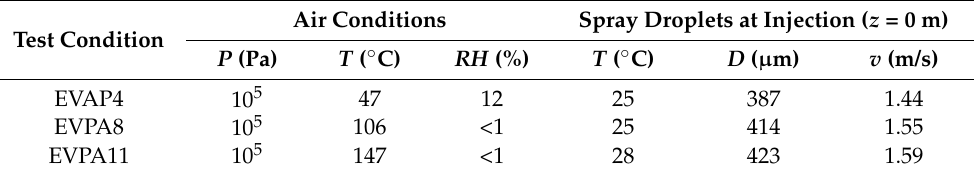
Table 1. Test conditions of three EVAP tests of the CARAIDAS program [52] used as benchmarks in this work. Test Condition